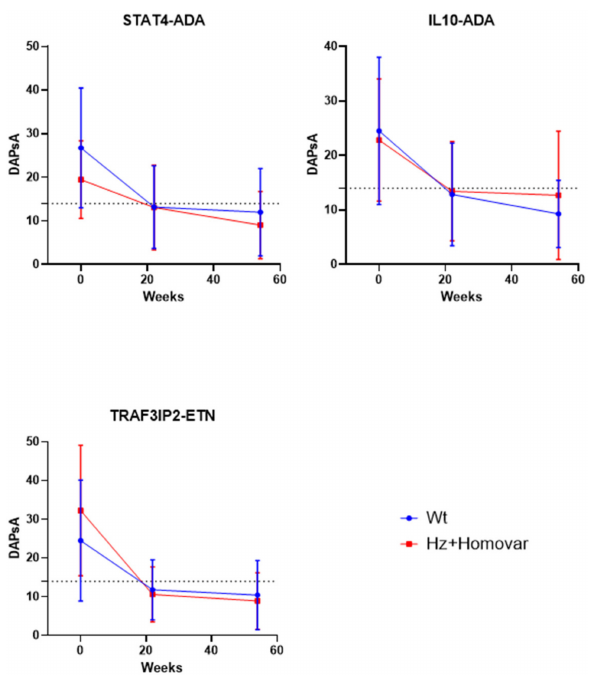
Figure 3. Mean differences of DAPsA values for single TNF-inhibitor treatment in the geno- typic classes for STAT4 , IL10 and TRAF3IP2 SNPs. ADA = adalimumab; ETN = etanercept; DAPsA = Disease Activity Index for PsA; Wt = wild-type genotype; Hz = heterozygous geno- type; Homo var = homozygous genotype. The dotted line indicates 15 DAPsA value corresponding to low disease